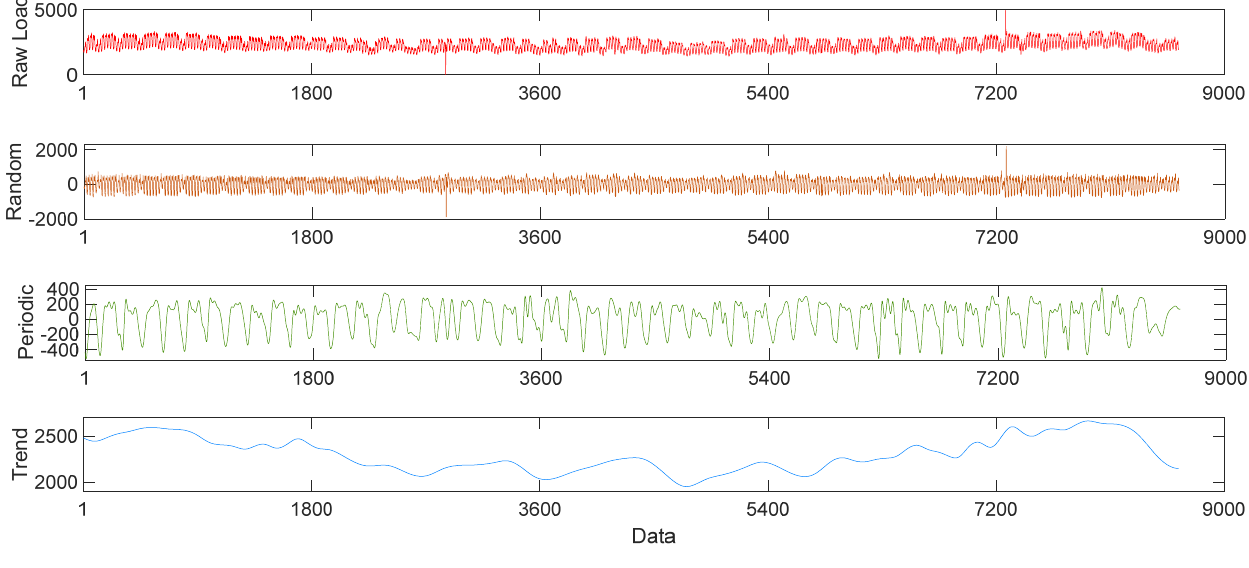
Table 4. Prediction results of different algorithms.